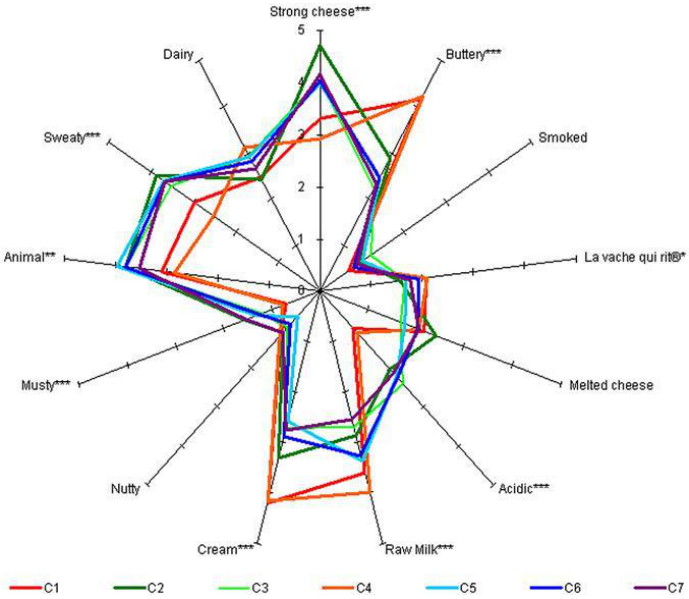
Figure 6. Mean ratings of the 13 odor attributes for the seven (C1–C7) semi-hard cheeses (13 judges; 3 repetitions). Significant differences are shown: * significant at p < 5%; ** significant at p < 1%; *** significant at p < 0.1% (reprinted from [173] with permission from Elsevier).